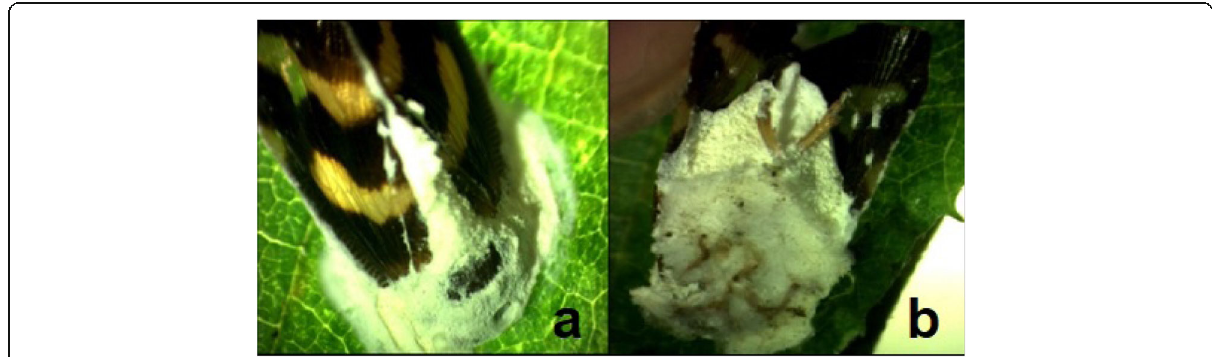
Fig. 3 Adult specimens of Orosanga japonica infected with Beauveria bassiana in the field. a Infected with isolate 2. b Infected with isolate 1